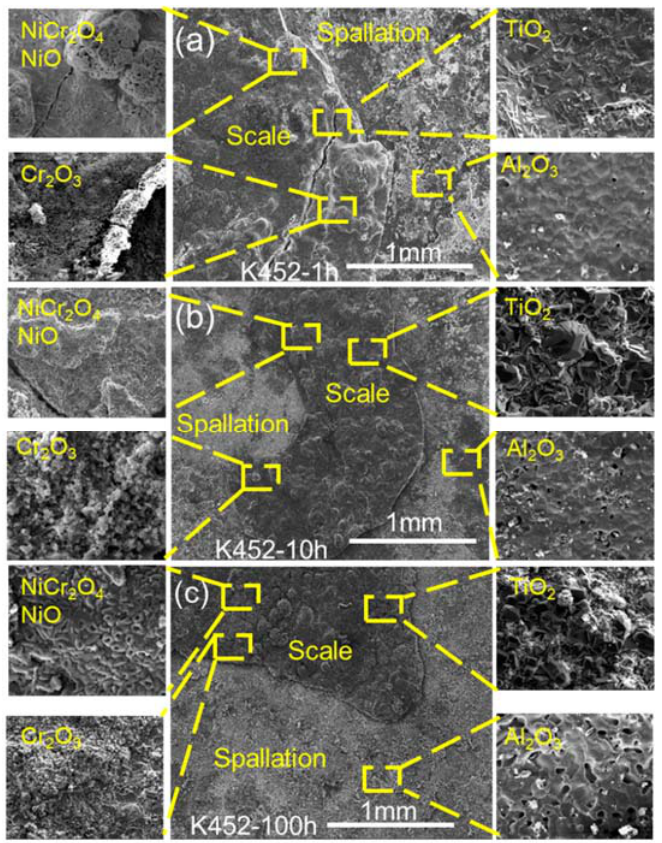
Figure 9. Surface morphology and composition of K452 after 1h, 10 h, and 100 h of continuous hot corrosion. ( a ) 1 h, ( b ) 10 h, and ( c ) 100 h.